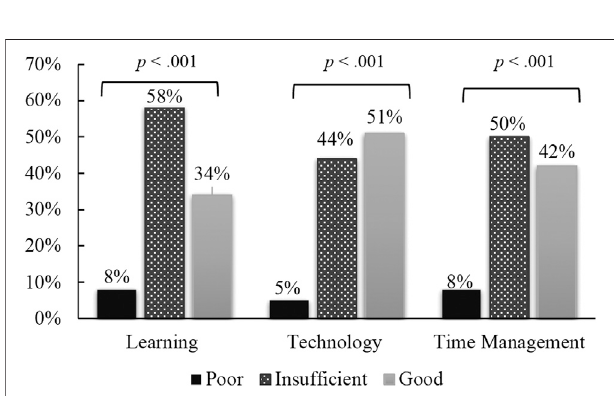
FIGURE 2 | Participants ’ responses to the electronic learning self- ef fi cacy domains. Fisher ’ s exact used in the